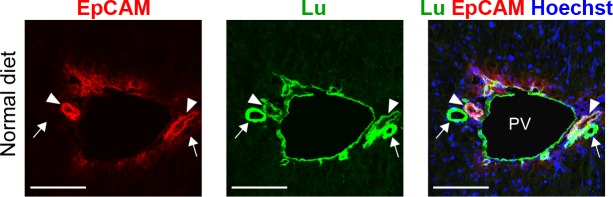
Co-staining of EpCAM and Lu in liver sections of normal liver.Arrows and arrowheads point to hepatic arteries and bile ducts, respectively. The fluorescence signal of Lu is weakly detected in EpCAM+ bile ducts, while it is saturated in EpCAM- hepatic arteries in this setting of exposure. PV: portal vein. Scale bar: 100 μm.